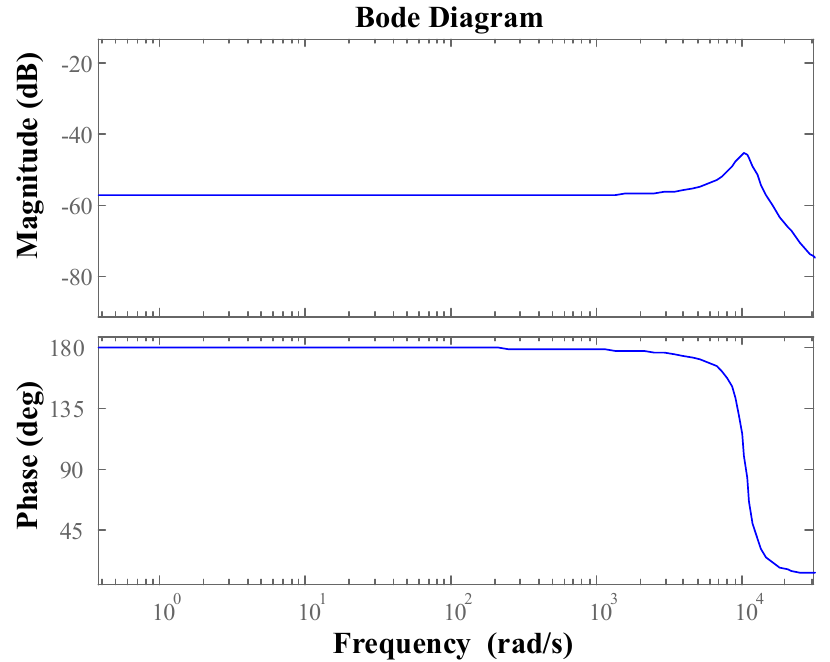
Figure 8. Transfer function from control to output voltage.